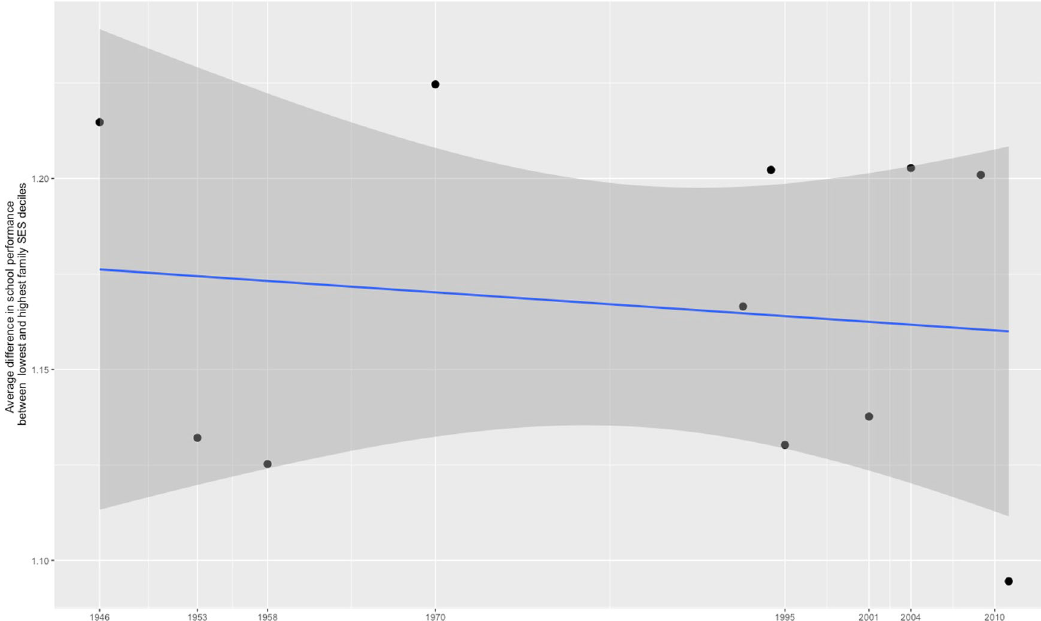
Fig. 4 Changes in the school performance gap between the highest and lowest family SES deciles from 1946 through 2011. Note. Points re fl ect distance in standardized school performance between highest and lowest SES decile, after adjusting for cohort-speci fi c characteristics. The line marks the linear regression; grey areas re fl ect Con fi dence Intervals of